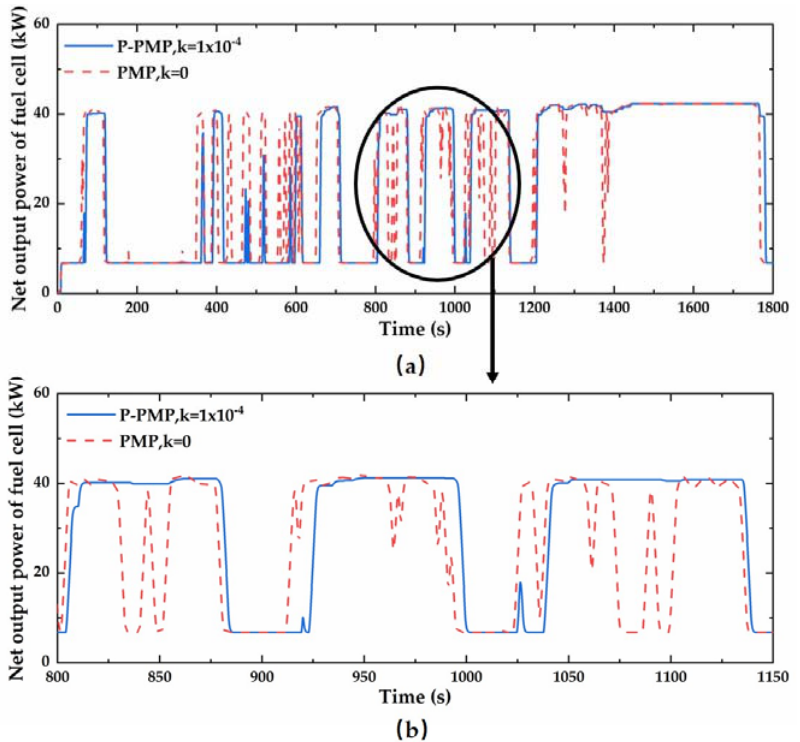
Figure 10. Comparison of the net output power of fuel cell under PMP and P-PMP. ( a ) Comparison of net output power of fuel cell; ( b ) Partial enlarged drawing.